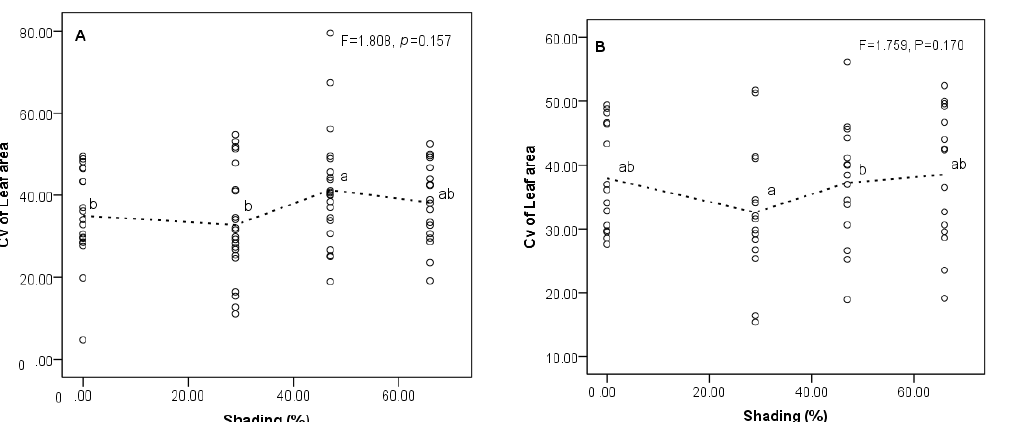
lower variation coefficients for LW (F = 4.788, p = 0.011) and CHL (F = 4.545, p = 0.014) than shrubs. No interaction of shading or life form effect was detected in this analysis.